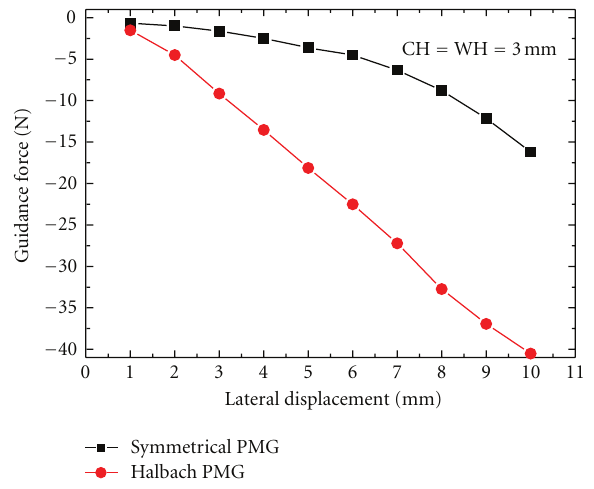
Figure 7: Guidance force-displacement curves of bulk HTS over two types PMG along x